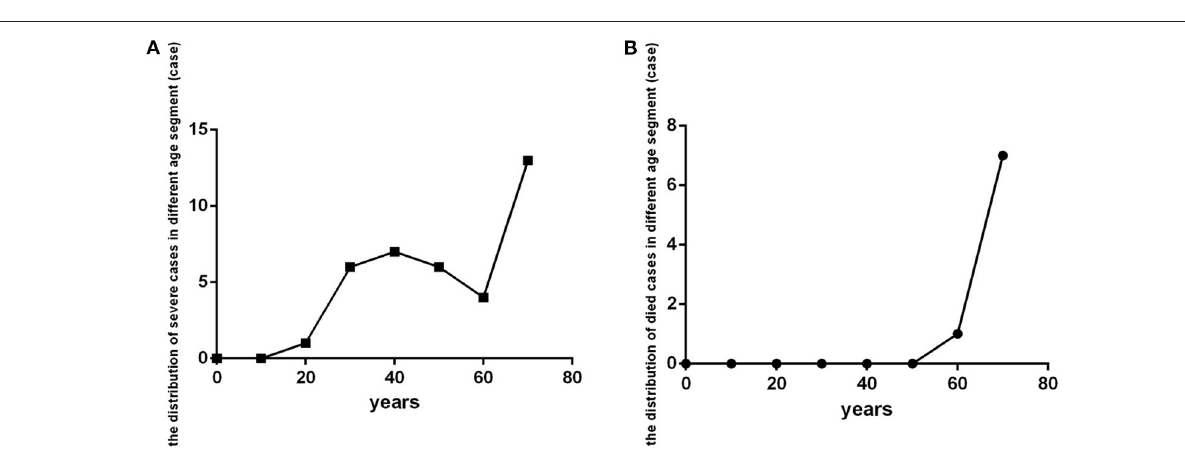
FIGURE 5 | The distribution of patients with severe COVID-19 and who died in different age-interval groups ( n = 718). COVID-19, coronavirus disease 2019. (A) Severe cases. (B) dead